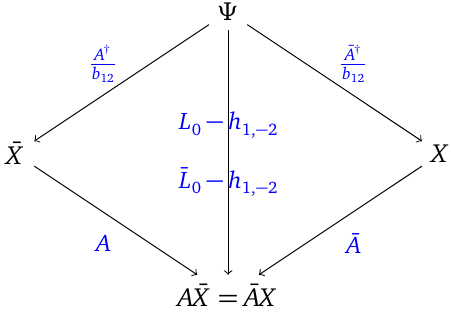
Figure 1: A diamond structure under V at generic